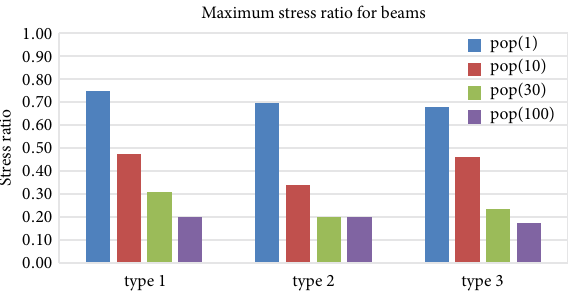
Fig. 11. The maximum stress ratio of beams for the second model Maximum stress ratio for beams